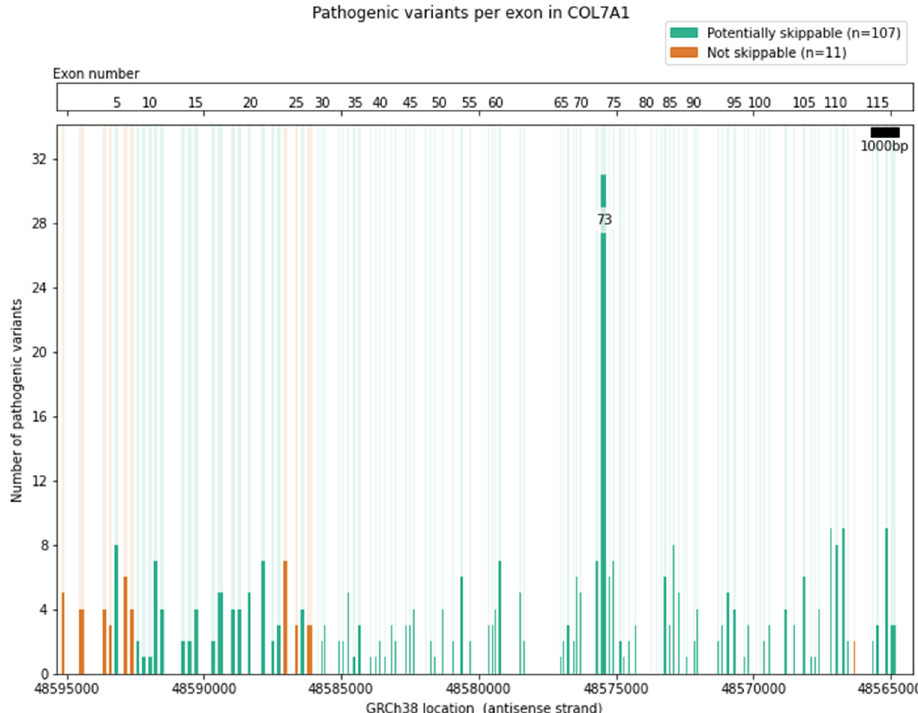
Figure 4. Schematic representation of the genomic structure of COL7A1 and pathogenic variants per exon. Light-green bars indicate in-frame (potentially skippable) exons, light-orange bars represent out-of-frame (non-skippable) exons. Exons are depicted to scale, the scale bar represents 1000 bps. Projected on top of each exon as dark-green and dark-orange bars are the number of pathogenic variants per exon, the height of each bar indicates the number of variants per exon. The top bar contains the exon numbers.